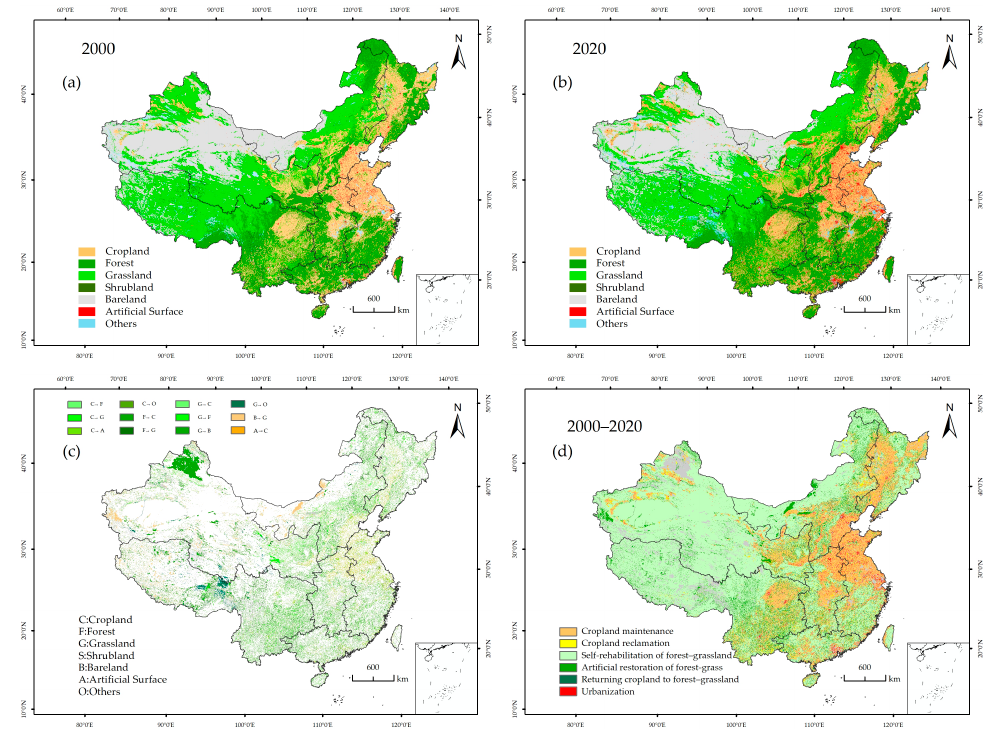
Figure 8. Land cover maps of China for ( a ) 2000 and ( b ) 2018, spatial patterns of ( c ) the dominant land cover change types, and ( d ) the six land cover categories.